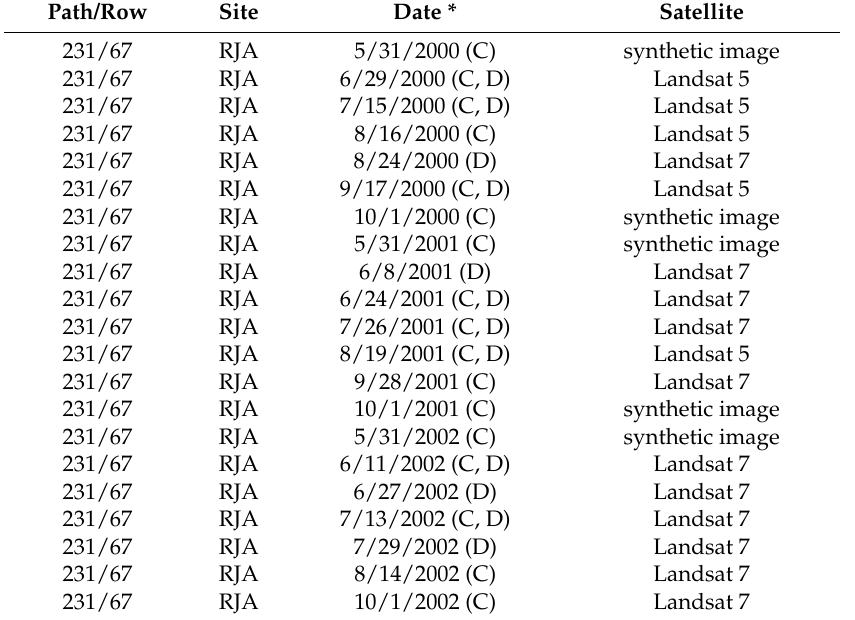
* C = images used for cubic spline interpolation of ET r F values. D = image dates for daily ET comparison between METRIC ET and flux tower (FT)